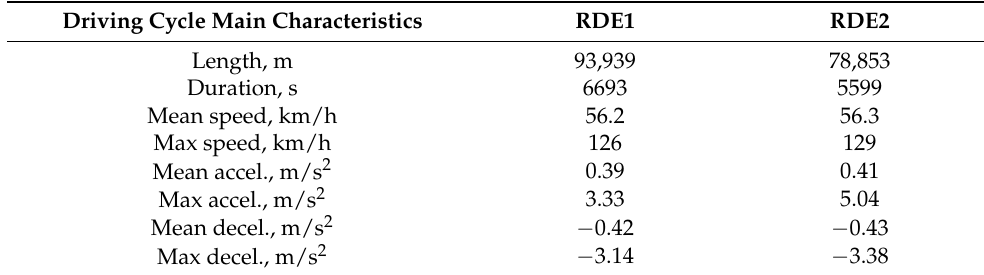
Table 4. RDE-compliant cycles main data. Reproduced from [27], Publications Office of the European Union: